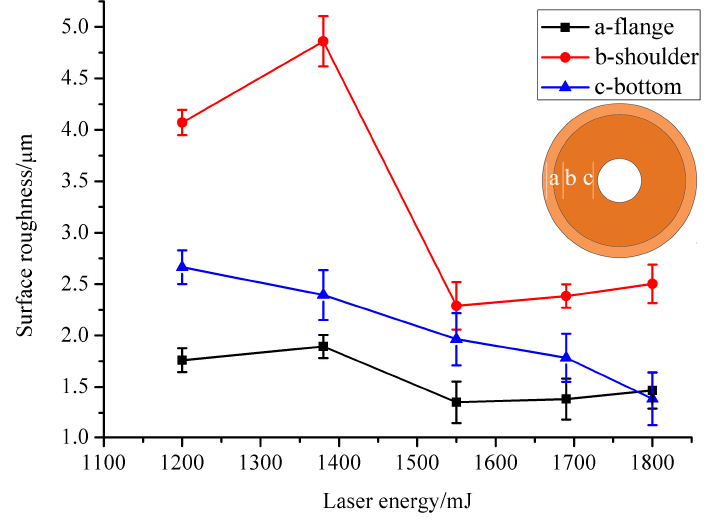
Figure 10. The relationship between the laser energy and the surface roughness value on three different